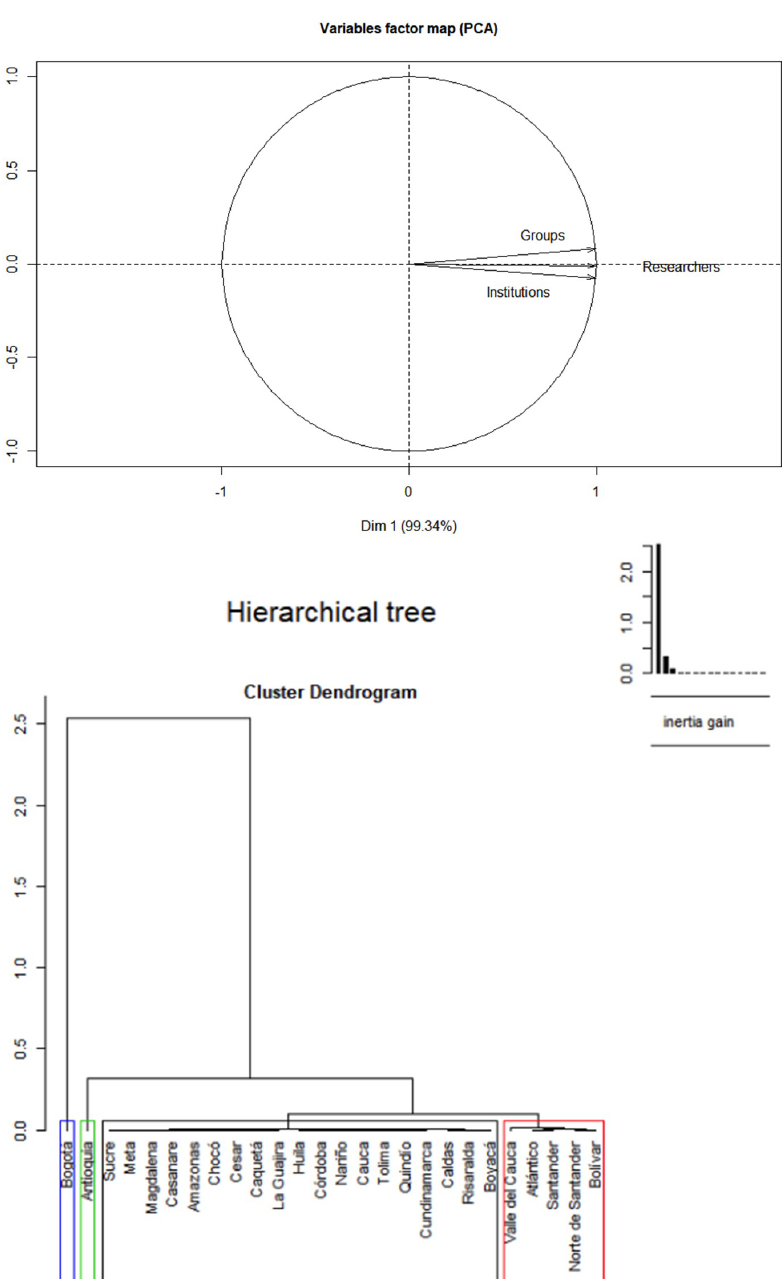
Figure 1. Factorial maps and hierarchal tree (using the Ward technique) of variables used to conform categories of Colombian departments. Table 1. Conforming categories in Colombian departments of study.